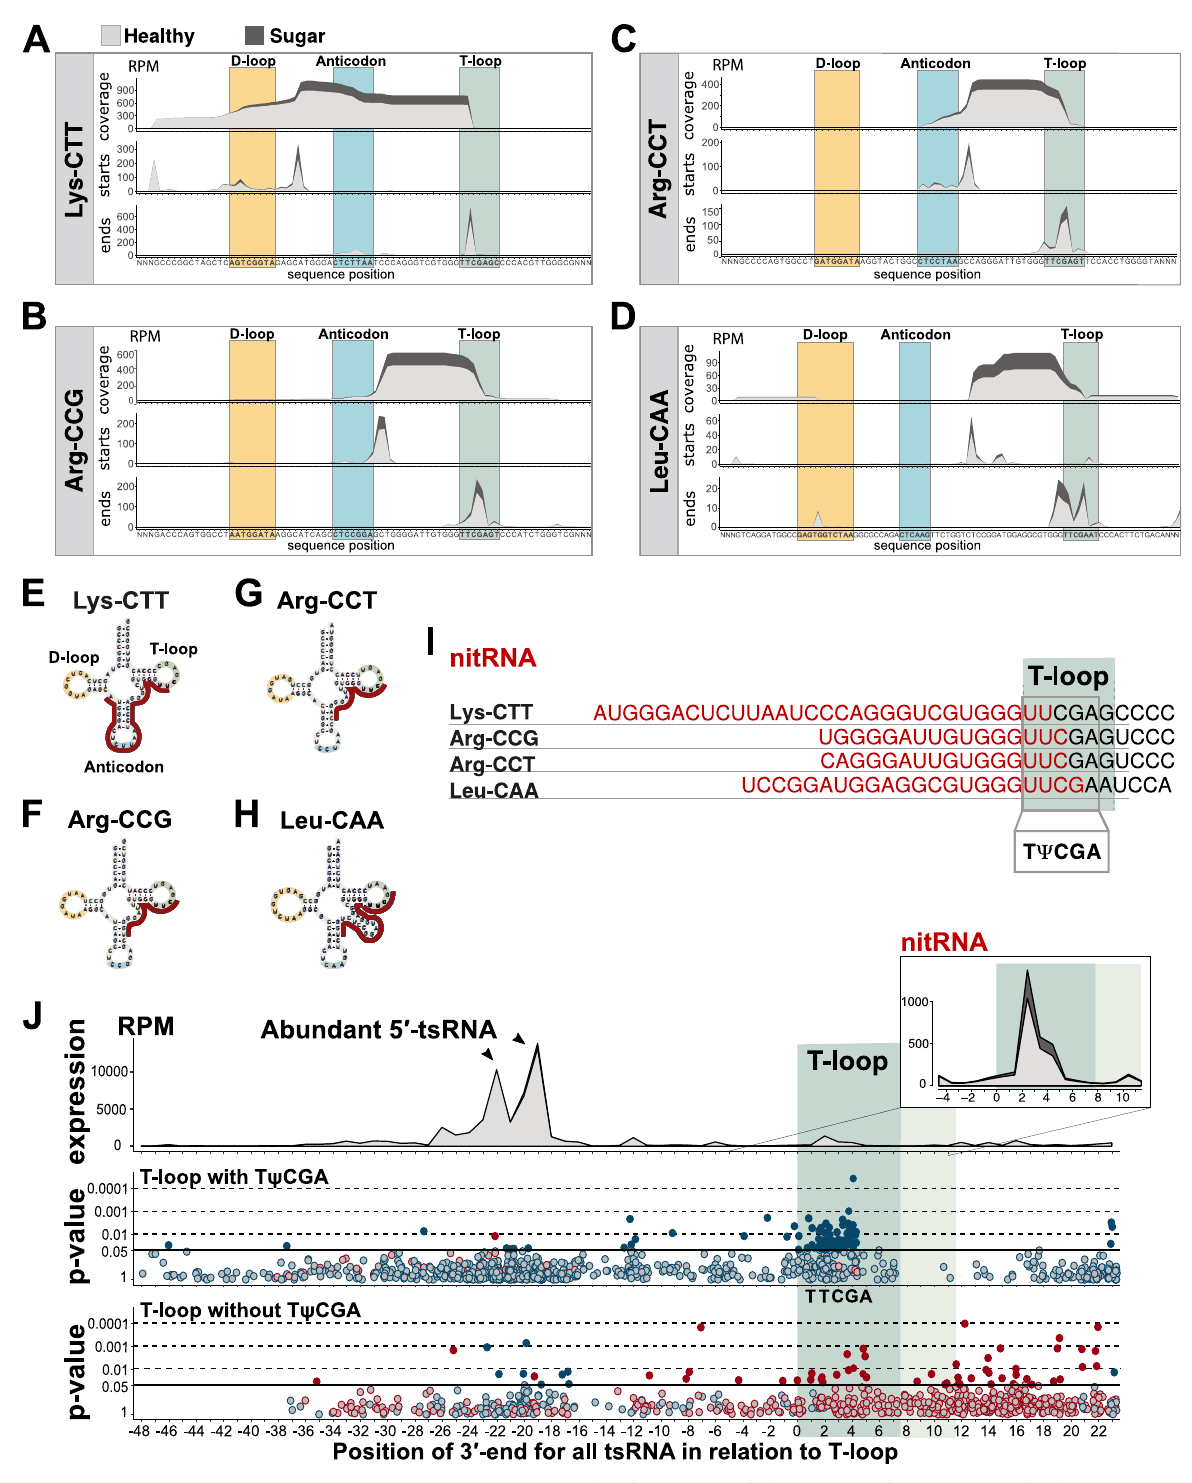
Fig 5. T-loop cleavage generates sugar-sensitive nitRNAs. (A–D) Nucleotide coverage and cleavage site analysis. (E–H) Graphical representation of tsRNAs generated in response to a high-sugar diet. (I) Shared T-loop sequence (T C CGA) across sugar-sensitive nuclear tsRNAs. (J) Positional analysis of 3 0 cleavage sites including all tsRNAs in the study. Top panel: Sugar (dark grey) versus Healthy (light grey) diet. Middle and bottom panels: significant tsRNAs (filled colored dots; p < 0.05), nuclear tsRNAs (blue), and mitochondrial tsRNAs (red). Data are available in S2 Data and S4 Table. nitRNA, nuclear internal T-loop tsRNA; RPM, reads per million; tsRNA, tRNA-derived small RNA.